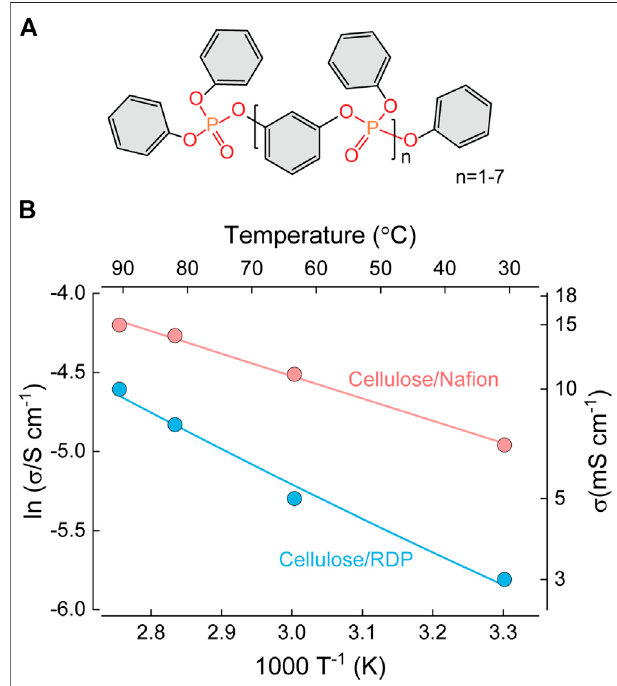
FIGURE 11 | (A) Chemical structure of resorcinol bis(diphenyl phosphate) (RDP). (B) Arrhenius plot showing the conductivity and activation energy of cellulose/Na fi on and cellulose/RDP membranes. Redrawn from Gadim et al. (2016), Wang et al. (2019).